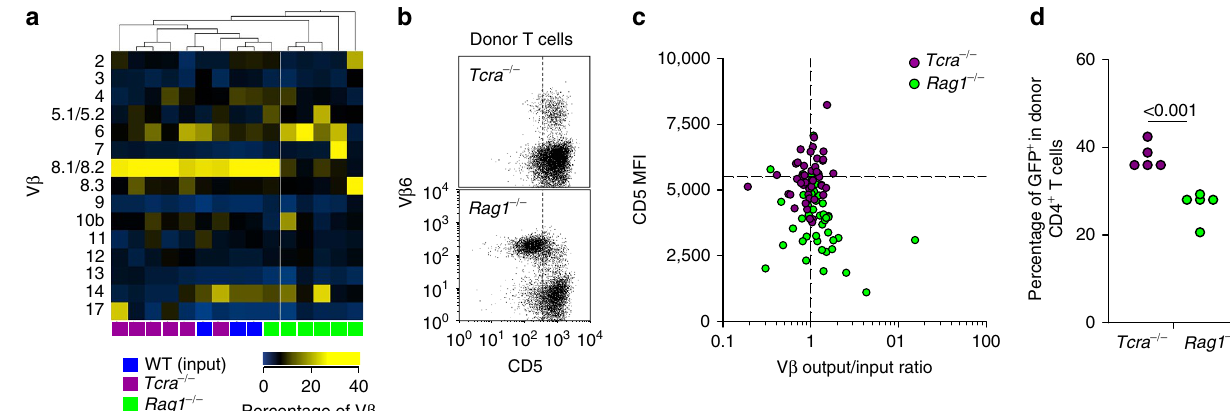
Figure 8 | Balanced TCR diversity during CD4 þ T-cell reconstitution requires B cells. ( a ) Heat-map of hierarchically-clustered WTdonors and Tcra (cid:2) / (cid:2) or Rag1 (cid:2) / (cid:2) Emv2 (cid:2) / (cid:2) recipients of purified CD4 þ Tcells according to the frequency of the indicated V b family before (WT (input)) or 21 days after T-cell reconstitution ( Tcra (cid:2) / (cid:2) or Rag1 (cid:2) / (cid:2) ). Each column is an individual mouse. ( b ) Flow cytometric detection of CD5 and V b 6 expression in donor CD4 þ T cells from the same recipients as in a . ( c ) CD5 median fluorescent intensity (MFI) plotted against the divergence from the input frequency of each detected V b family in donor CD4 þ Tcells from the same recipients as in a . Only three recipients are plotted for clarity. The horizontal dashed line represents the CD5 MFI in control cells ( P o 0.001 between CD5 levels in Tcells from the two types of host, Mann–Whitney rank sum test). ( d ) Frequency of GFP þ cells in donor CD4 þ T cells 21 days after T-cell reconstitution of Tcra (cid:2) / (cid:2) or Rag1 (cid:2) / (cid:2) Emv2 (cid:2) / (cid:2) ( Rag1 (cid:2) / (cid:2) ) recipients with purified CD4 þ T cells from Nur77-GFP transgenic donors. Each symbol represents an individual mouse. ( Tcra (cid:2) / (cid:2) ) or both T and B cells ( Rag1 (cid:2) / (cid:2) ) were reconstituted the pattern of V b usage in the input population, as the two were by adoptive transfer of fully polyclonal purified CD4 þ T cells and indistinguishable by unsupervised clustering (Fig. 8a). In contrast, usage of different families of V b chains was compared between T-cell reconstitution of Rag1 (cid:2) / (cid:2) hosts resulted in considerable the input and expanded population in the respective host 21 days skewing in V b usage in 5 out of 6 such hosts, which clustered later (Fig. 8a). T-cell reconstitution of Tcra (cid:2) / (cid:2) hosts preserved separately from all other hosts (Fig. 8a). TCR V b usage skewing NATURE COMMUNICATIONS|7:10281|DOI: